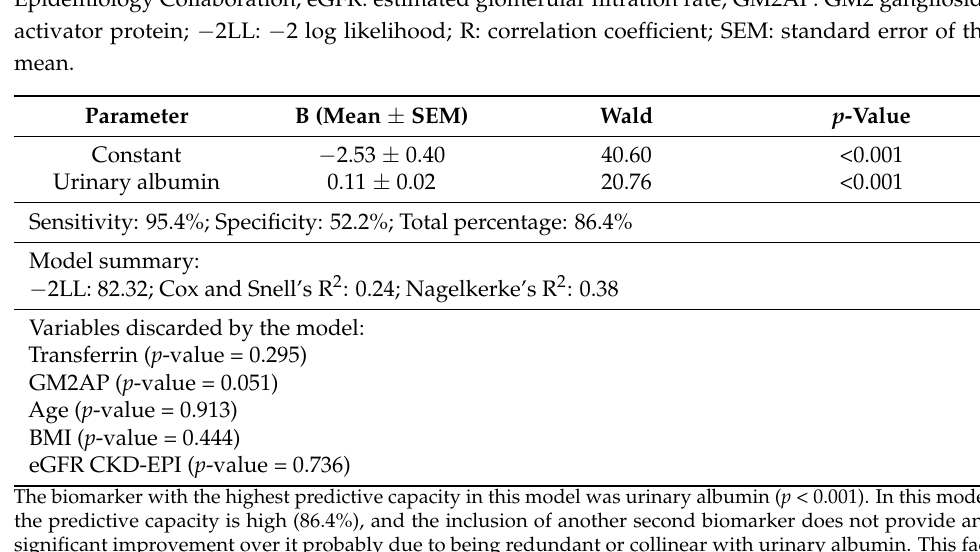
Table 2. Results of the binary logistic regression analysis applied on urinary albumin, GM2AP and transferrin; age, BMI and eGFR CKD-EPI. BMI: body mass index; CKD-EPI: Chronic Kidney Disease Epidemiology Collaboration; eGFR: estimated glomerular filtration rate; GM2AP: GM2 ganglioside